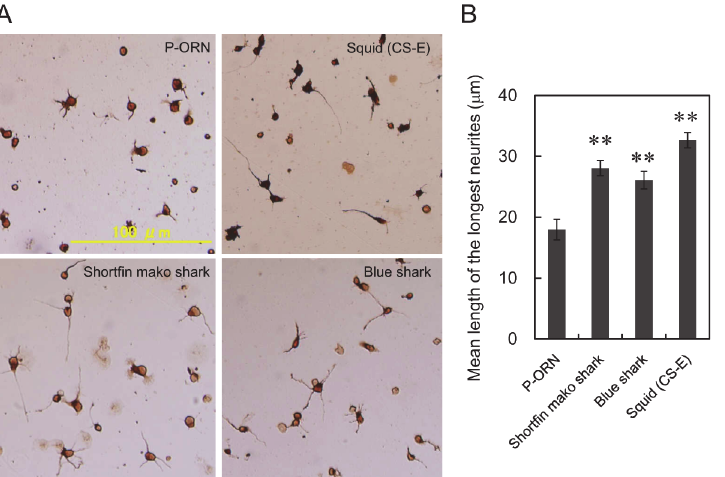
Fig 3. Effect of shark CS/DS from shortfin mako shark (Fr. 5) and blue shark (Fr. 3) on neurite outgrowth. (A) Representative morphological features of E16 hippocampal neurons cultured with shark CS/ DS. E16 hippocampal neuronal cells (16000 cells/cm 2 ) were cultured for 18h on various substrates coated on P-ORN, fixed and immunostained as described under “ Materials and Methods ” . (B) The mean length of the longest neurite was measured for more than 50 randomly selected neurons cultured on various substrates (see “ Materials and Methods ” ). The values obtained from six independent experiments are expressed as the mean ± S.E. Mann-Whitney ’ s U test was used to evaluate the significance of differences between means ( ** , p <